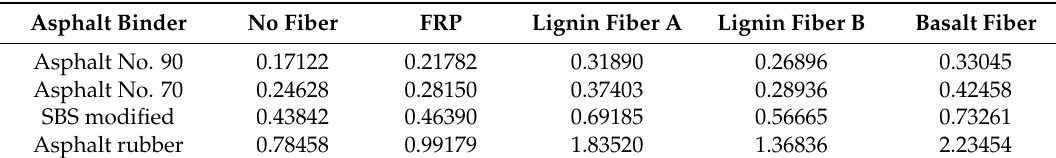
Table 7. Shear strength of asphalts without fiber and with 2% fiber (kPa).